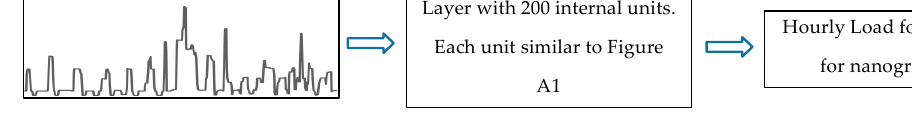
Figure A1. LSTM structure [56].